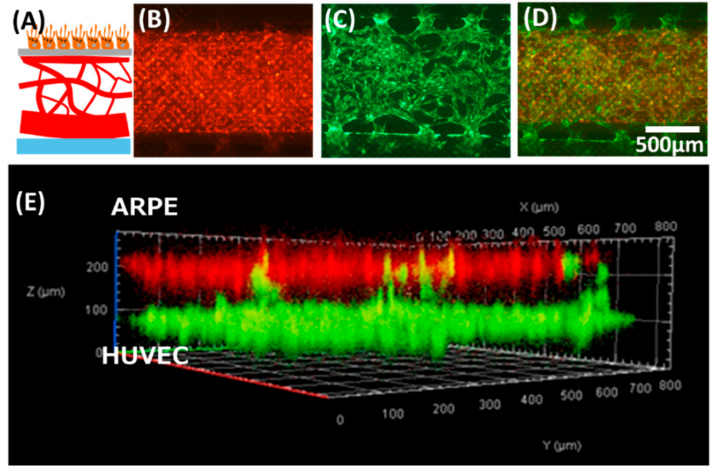
Figure 3. The oBRB model prototype built using the proposed device. ( A ) Schematic showing the anatomical structure of oBRB (retinal pigment epithelial cells–Bruch membrane-choroids). ( B – E ) tri-culture of ARPE–human umbilical vein endothelial cells (HUVEC)-human lung fibroblasts (NHLF). ( B ) ARPE cells stained in red were cultured in the upper channel. ( C ) GFP-HUVEC microvessels were cultured in the lower channel. ( D ) Overlay of ( B ) and ( C ). ( E ) Confocal microscopic view of the cross-section of the co-culture